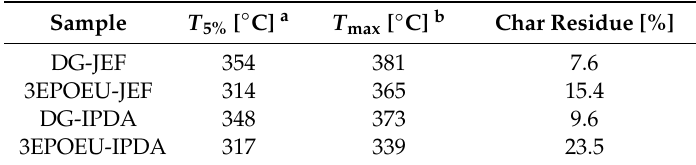
Table 3. Thermogravimetric data of the formulations studied. Figure 3. Thermogravimetric analysis (TGA) ( a ) and Differential thermogravimetry DTG ( b ) curves under N 2 atmosphere at 10 °C/min of the materials studied.